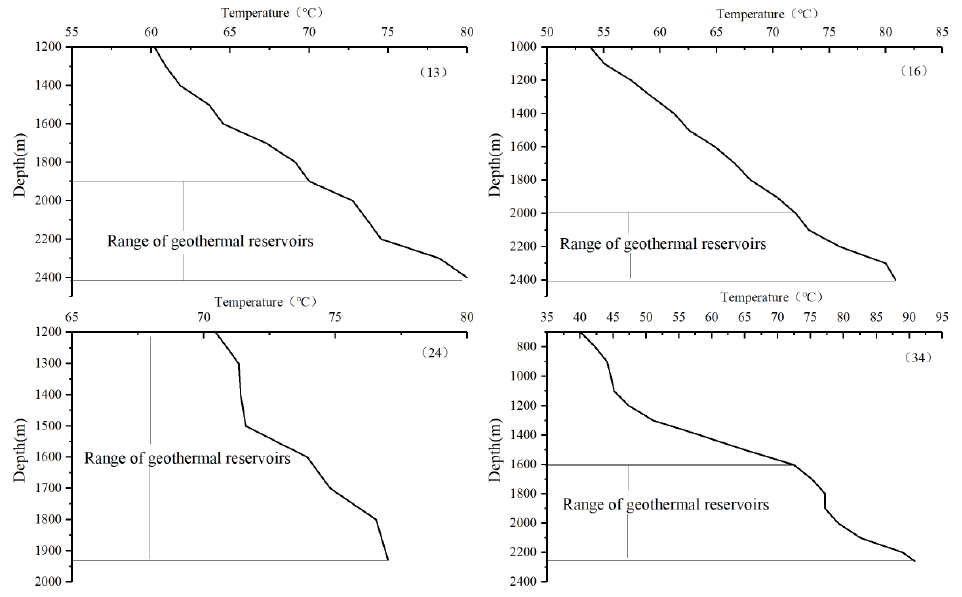
Figure 3. Geothermal borehole depth–temperature profile. Table 2. Measured temperatures and geothermometer estimates (°C).